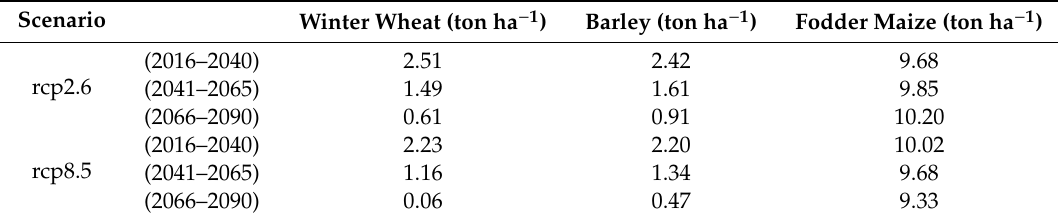
Table 10. Results of the actual yield of the crops under scenarios rcp2.6 and rcp8.5 for periods 2016–2040,